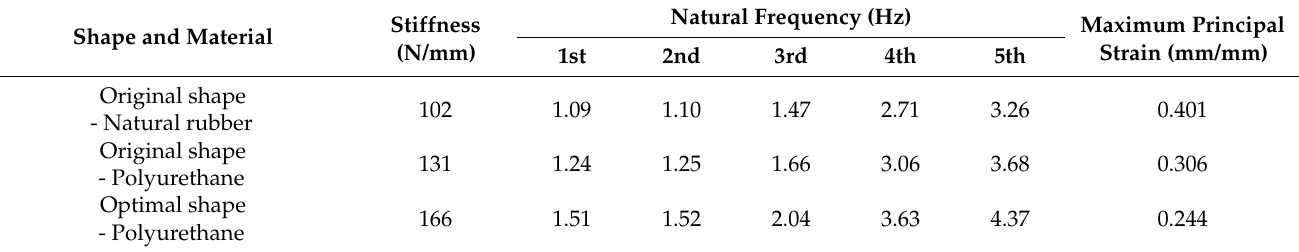
Table 8. Comparison of stiffness, natural frequency and maximum principal strain according to shape and material.